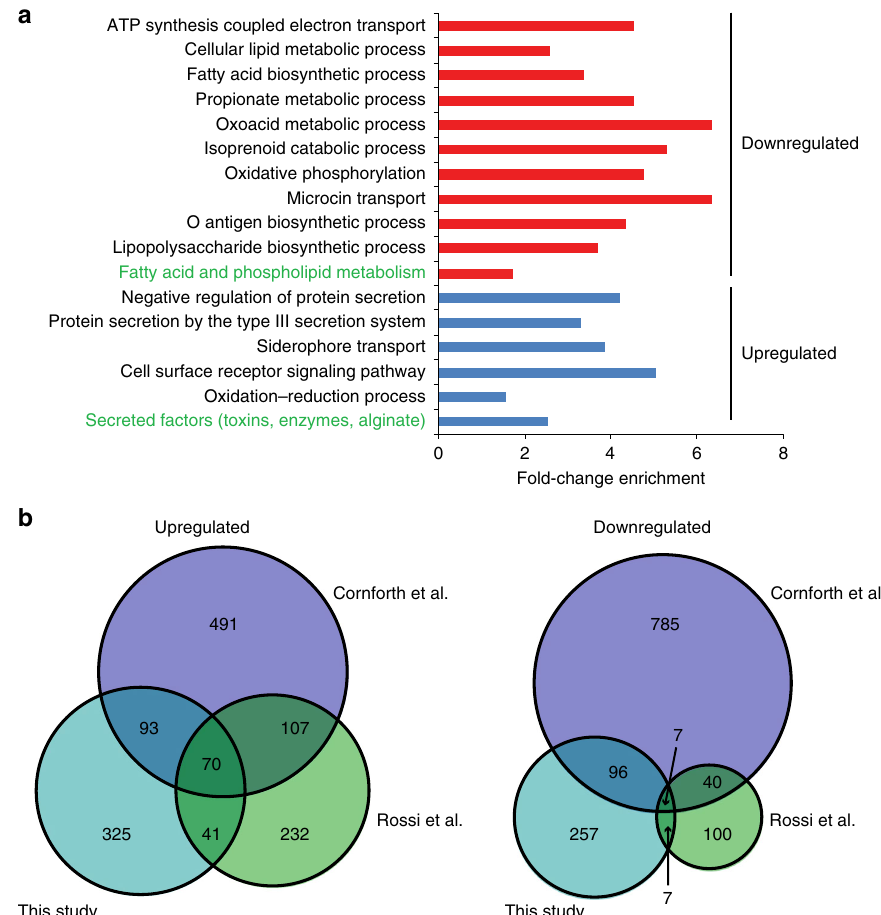
Fig. 6 Cystic fi brosis (CF) habitat-speci fi c transcriptional pro fi le. Genes that were differentially expressed (log 2 fold change (FC) ≥ 1.5) in the ex vivo transcriptional pro fi le compared to the in vitro condition were assigned to GO terms and PseudoCAP categories (green text). The enrichment factor is depicted in a and provides information on the proportion of regulated genes belonging to a functional category relative to the proportion of all genes (that were considered for differential expression analysis) belonging to that category. Categories with signi fi cantly enriched genes are depicted (hypergeometric test, adjusted p value ≤ 0.05), while fold-change enrichment is indicated at the x axis. Source data are provided as a Source Data fi le. b